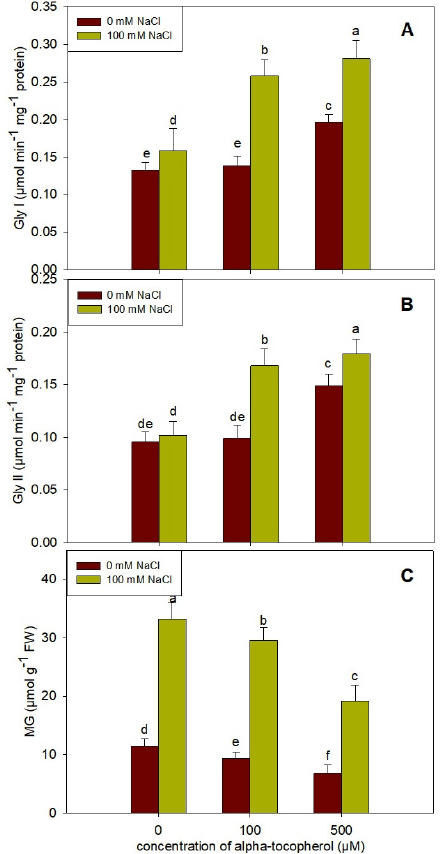
Fig. 5: Effect of increased salinity (100 mM NaCl) stress with and without exogenous application of α - tocopherol (100 and 500 μM) on the ac - tivity of (A) glyoxylase I, (B) glyoxylase II and (C) methylglyoxal content in soybean ( Glycine max ). Values are mean (±SE) of five rep - licates and different letters represent significant difference at